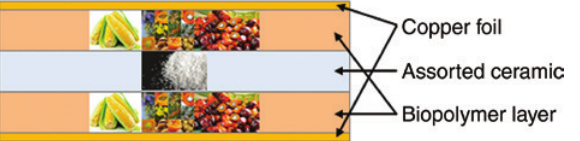
Figure 1: Composition of the ceramic-filled biopolymer substrate material.